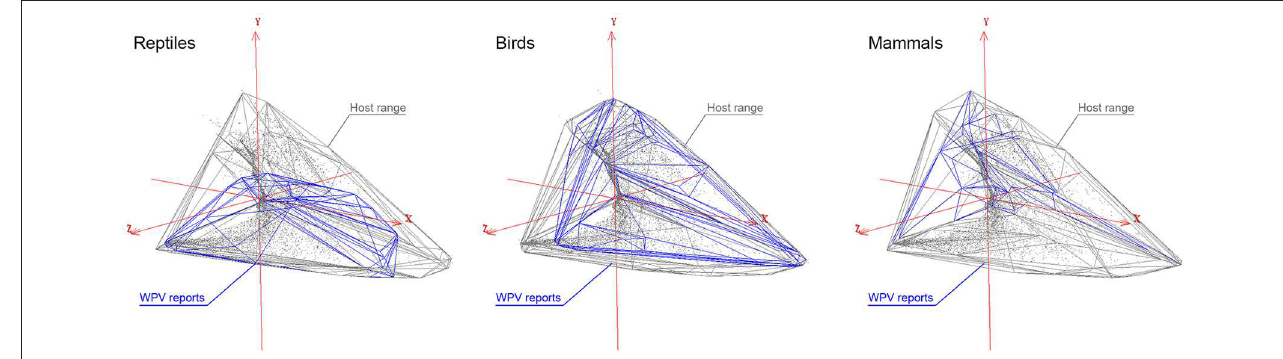
FIGURE 5 | Environmental distribution of the WPV hosts. The first three principal components (X, Y, Z axes) from the original bioclimatic data representing the three-dimensional environmental space (red lines). Distribution of WPV hosts (gray convex polyhedron) and WPV-reports (blue convex polyhedron) are displayed in the environmental space. From left to right: reptiles, birds, and mammals. Gray dots represent single environmental conditions available in the world.